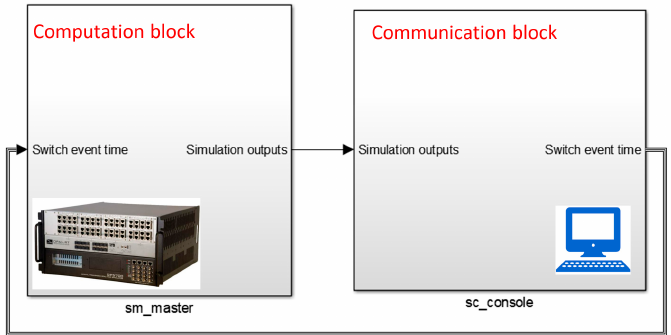
Figure 8. The top level of the Simulink model as used in the ePHASORSIM simulation for HIL.